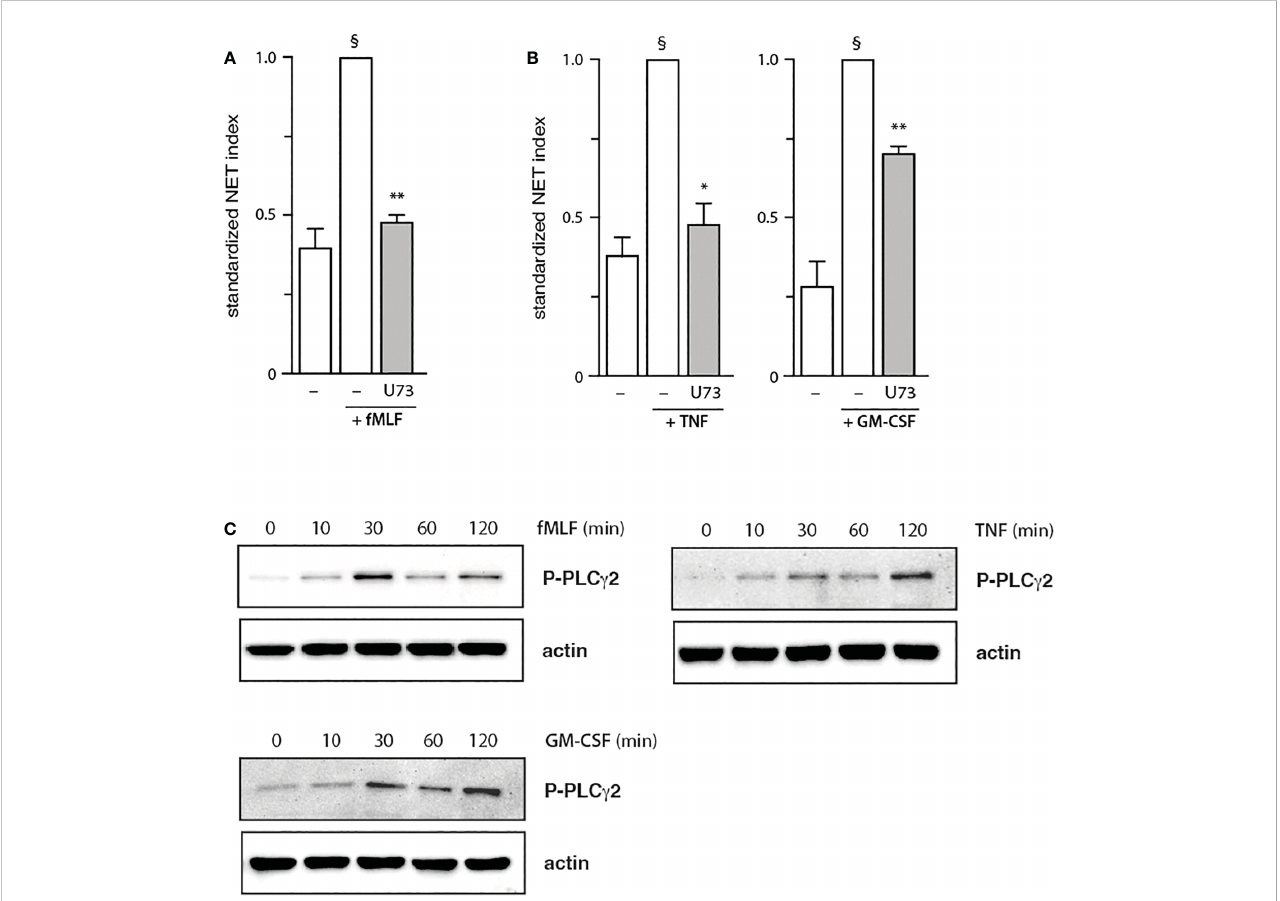
FIGURE 5 Role of PLC g 2 in NET formation. Neutrophils cultured on poly-L-lysine-coated coverslips were pre-treated (15 min, 37°C) with 1 m M U73122 ( “ U73 ” ) or its diluent (0.1% DMF), prior to a 4-h stimulation with 100 nM fMLF (A) or with 100 U/ml TNF a , or 1 nM GM-CSF (B) . NET formation was assessed using PlaNET Green as described in Methods . Mean ± s.e.m. from at least 3 independent experiments. *, p<0.05; **, p<0.01 vs stimulus alone. §, p < 0.02 for unstimulated cells vs stimulus. (C) Adherent neutrophils were stimulated for the indicated times at 37°C with 100 nM fMLF, 100 U/ml TNF a , or 1 nM GM- CSF. Samples were processed for immunoblot analysis of P-PLC g 2 (Y1217) as well as b -actin (loading control). Representative blots are